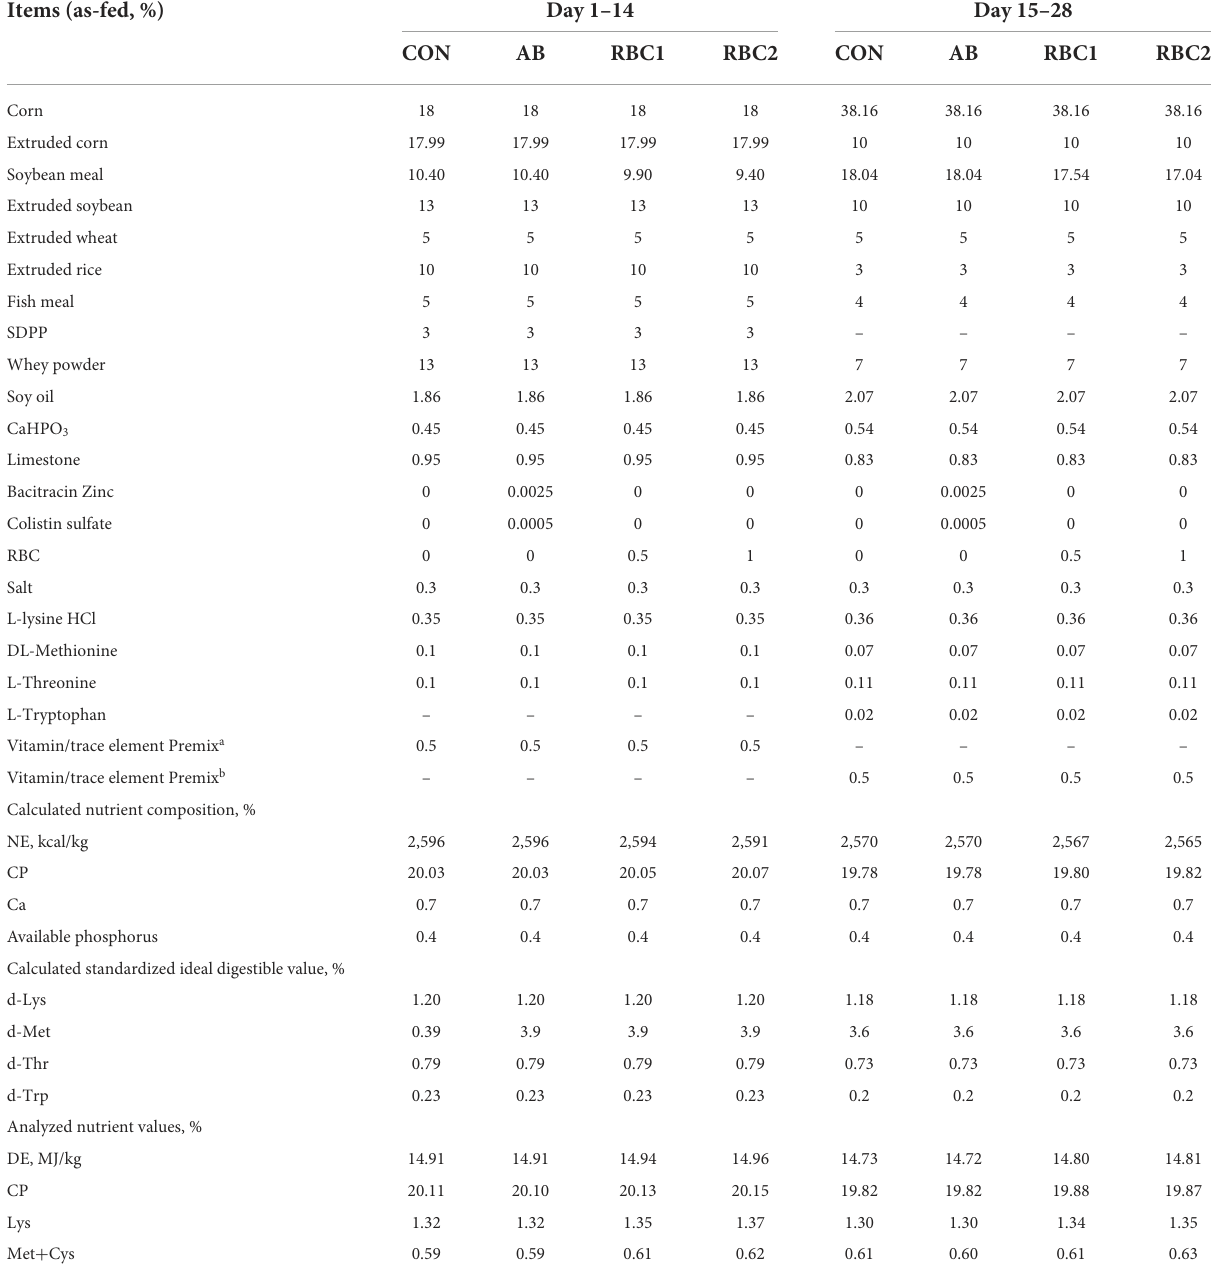
TABLE 1 Ingredients and composition of basal